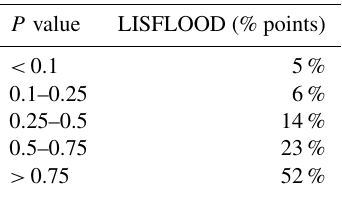
Earth Syst. Sci. Data, 14, 1549–1569,